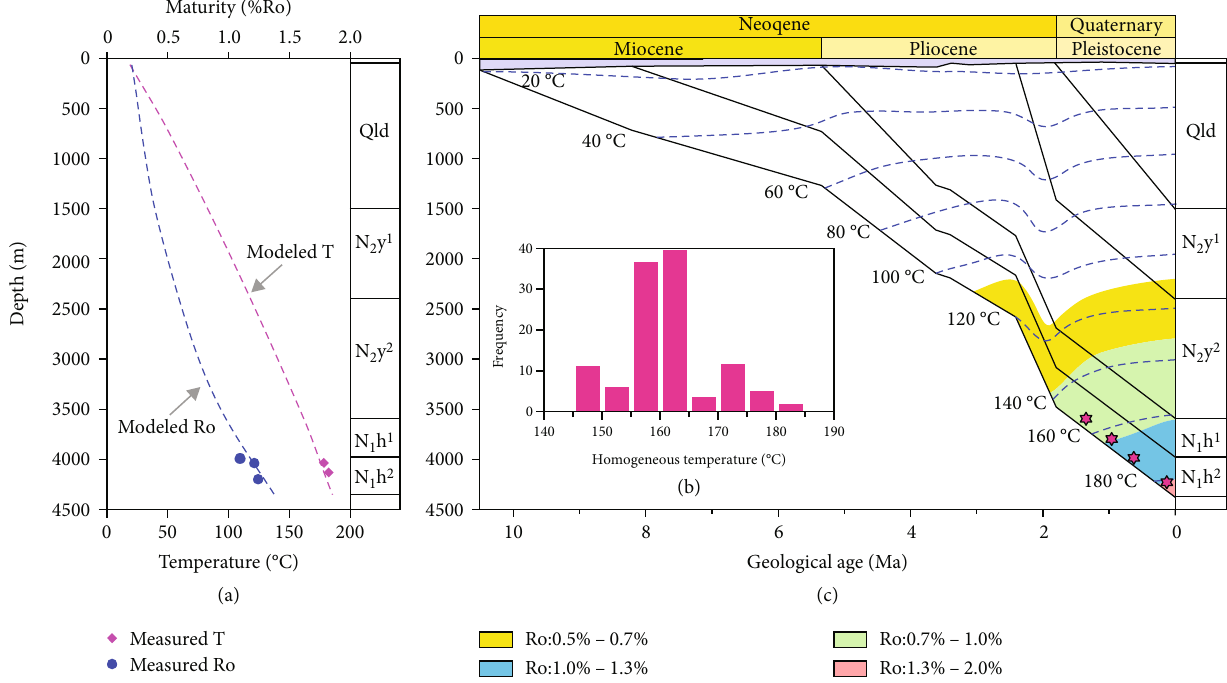
Figure 12: The natural gas charging period of the LD-B Wellblock in the Yinggehai Basin. (a) Modeled maturity and temperature with test data calibration, (b) homogeneous temperature of inclusions (modi fi ed from [41]), and (c) burial-thermal history and the charging time of natural